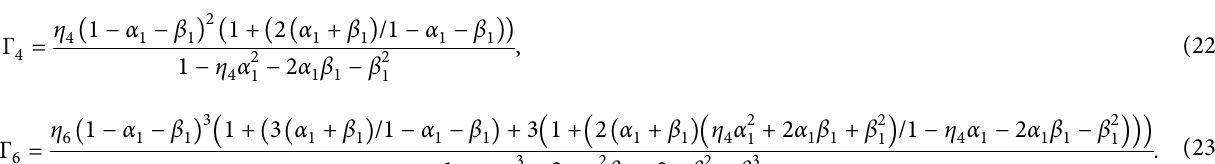
diagrams be started from points above the dashed line, Figure 6. As such only data above the dashed line can be described by a GARCH-double-normal model (which is the case for the empirical data collected for the securities we have considered here). 5.1. Time Windows. In Figure 6, we see three-parameter diagrams for three different double Gaussian distributions. Parameters for these diagrams are given in Table 2.